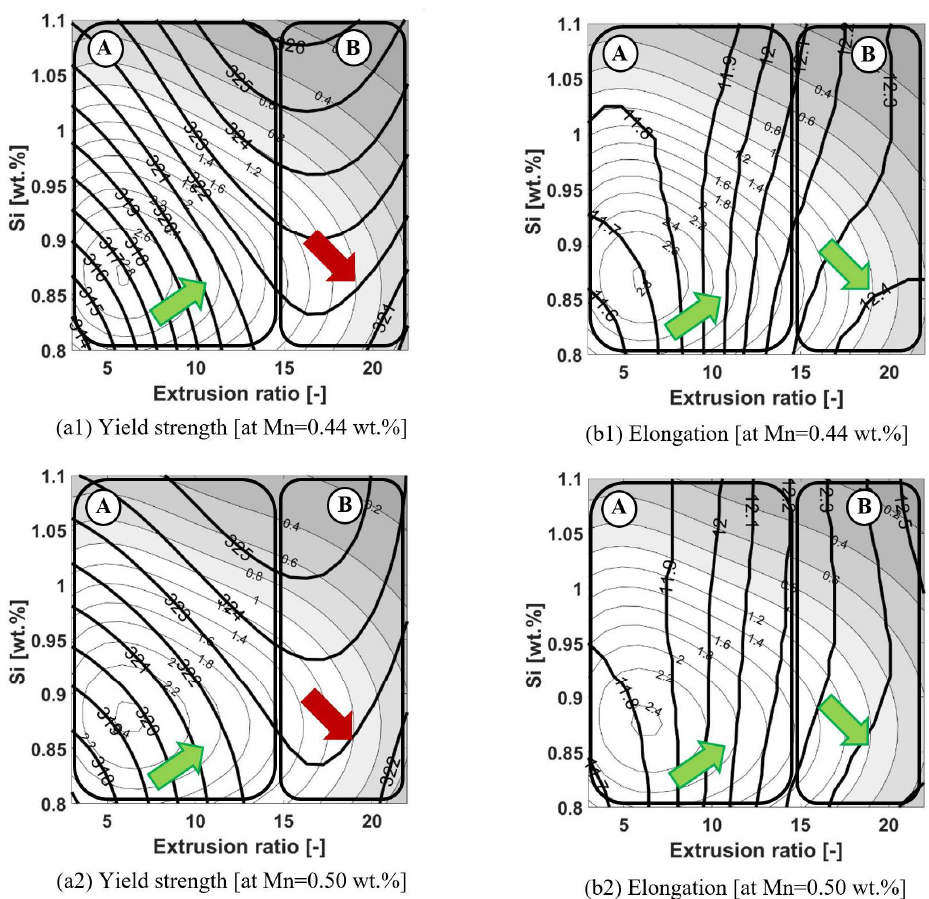
Figure 9. Common influence of extrusion ratio and Si content on yield strength and elongation at fixed values of Mn (Mn = 0.44 wt.% top, and Mn = 0.50 wt.% bottom).